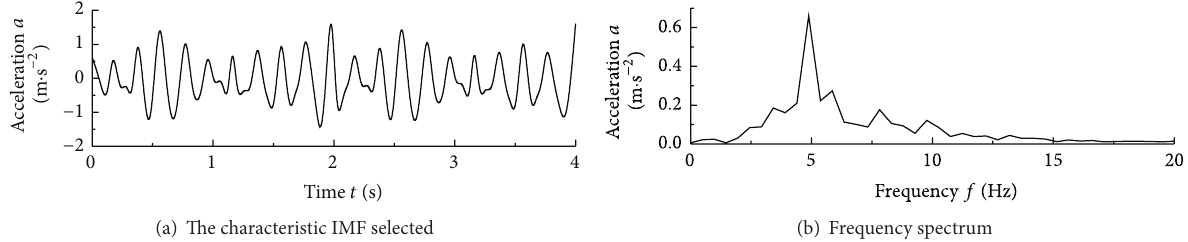
Figure 24: Analysis results of the signal presented in Figure 23 by improved EMD: (a) the characteristic IMF and (b) FFT spectrum.